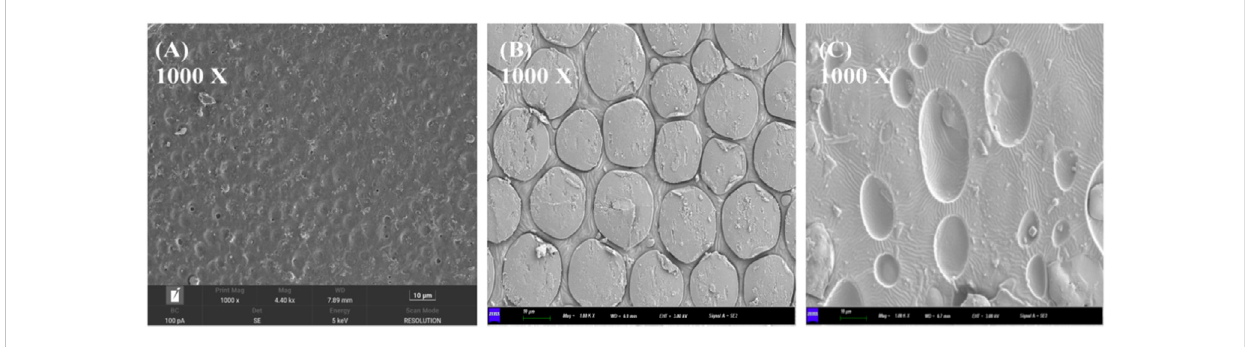
FIGURE 2 Scanning electron microscope images and magni fi cation distribution of (A) 10% drug-loaded fi lm; (B) 20% drug-loaded fi lm; (C) 30% drug- loaded fi lm.